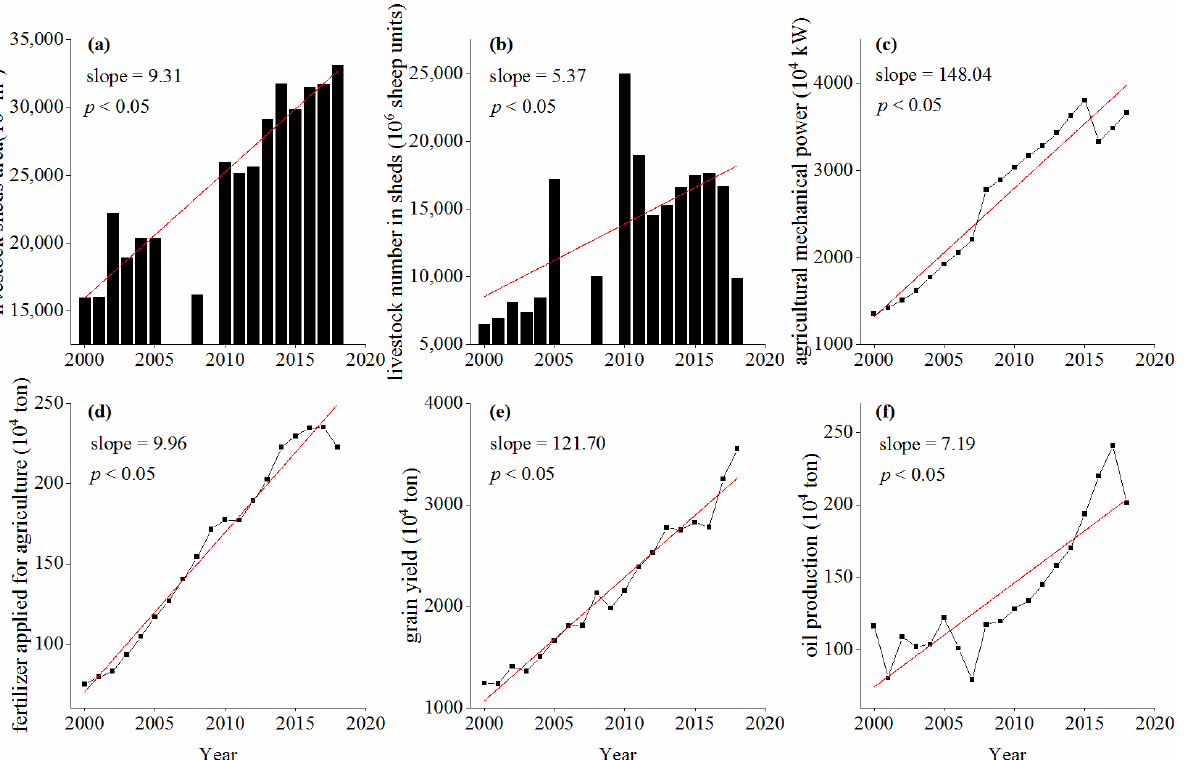
Figure 10. Inter-annual variations in ( a ) livestock shed area, ( b ) livestock numbers in sheds, ( c ) the total agricultural mechanical power, ( d ) the amount of fertilizer applied for agriculture, ( e ) the grain yield, and ( f ) the oil production in Inner Mongolia from 2000 – 2018. Note: The data were obtained from the Inner Mongolia Statistical Yearbook [79]. In ( a , b ), the data for livestock shed area and livestock numbers in sheds for 2006, 2007, and 2009 are not recorded in the Inner Mongolia Statistical Yearbook.